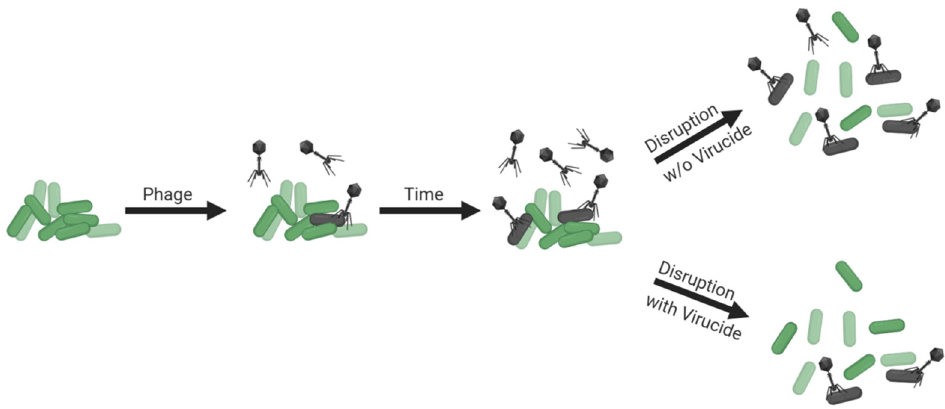
Figure 6. Illustration of greater susceptibility of bacteria to phage adsorption given biofilm disruption without virucides present (or without sufficient dilution; top ) or with virucides present (or with sufficient dilution; bottom ). Bacteria adsorbed by phages are indicated to the right. Created with BioRender.com.